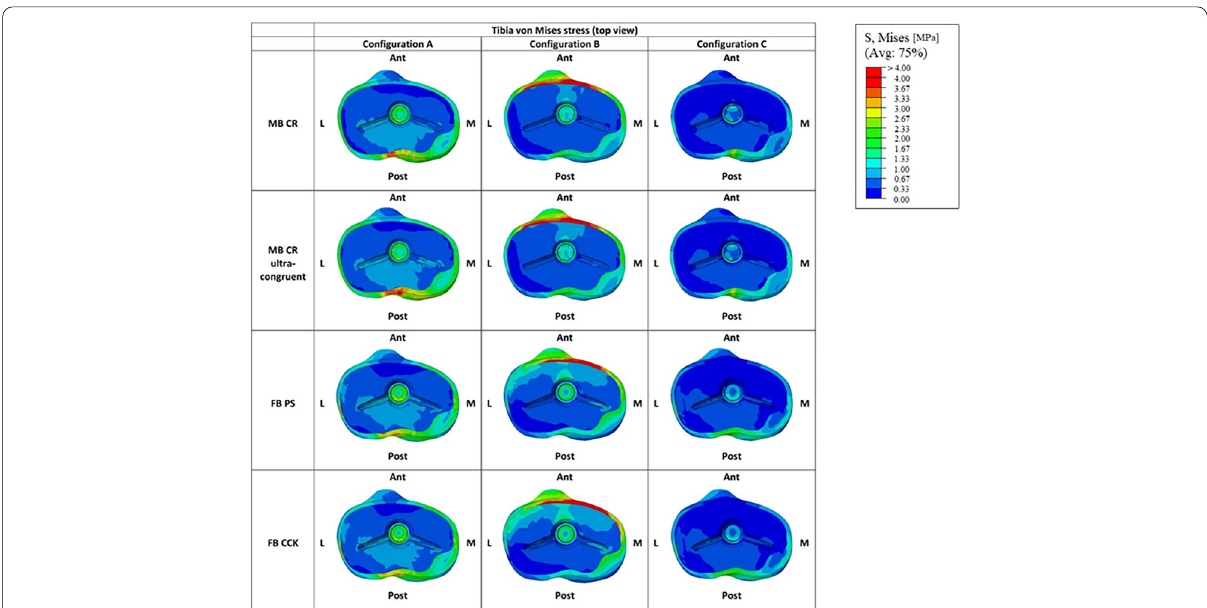
Fig. 10 Graphic overview of the von Mises stresses in the tibial bone interface for all the considered models in the three studied configurations. (M medial, L lateral, Ant anterior, Post = = = =